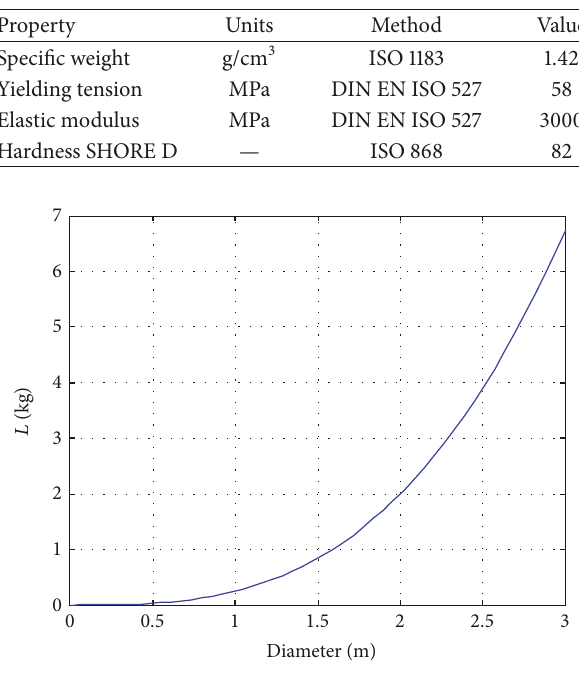
Table 6: PVC mechanical characteristics.